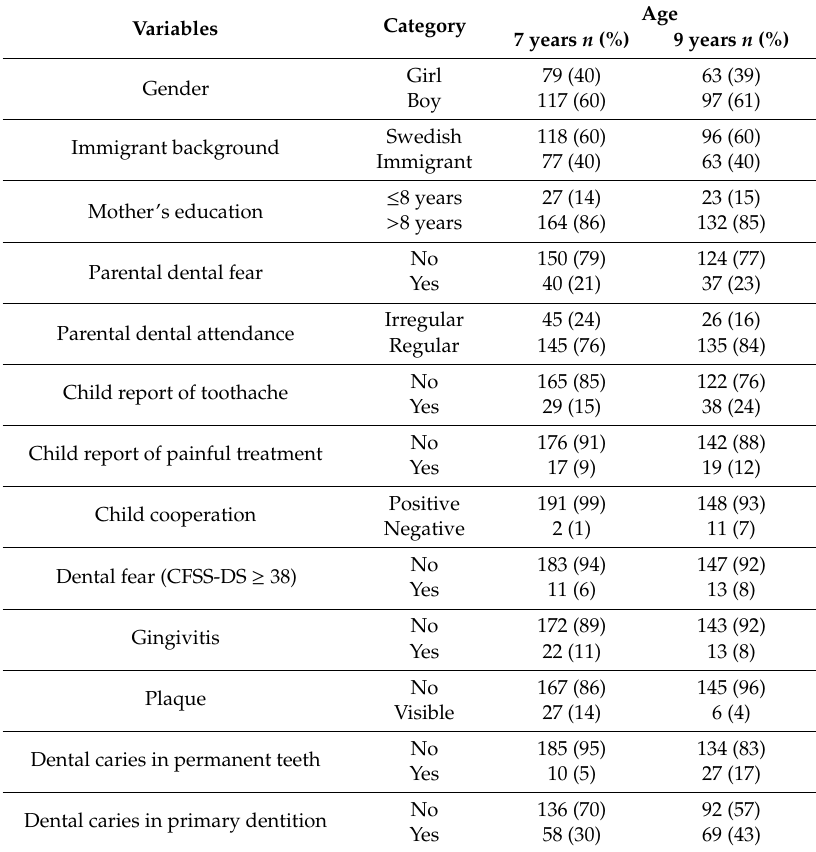
Table 1. Characteristics of children at ages seven and nine